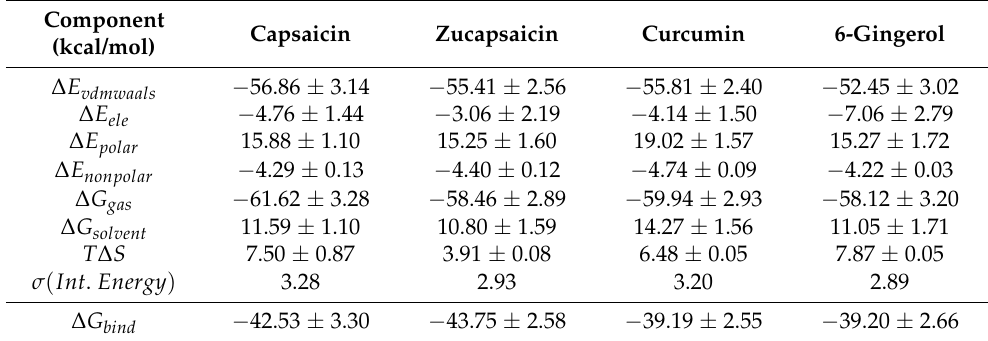
Table 1. Binding free energies in the capsaicin, zucapsaicin, curcumin and 6-gingerol system